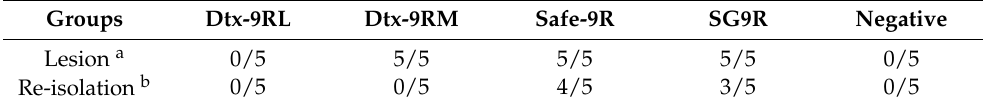
Table 2. Re-isolation of detoxified strains in protein-energy malnutrition model